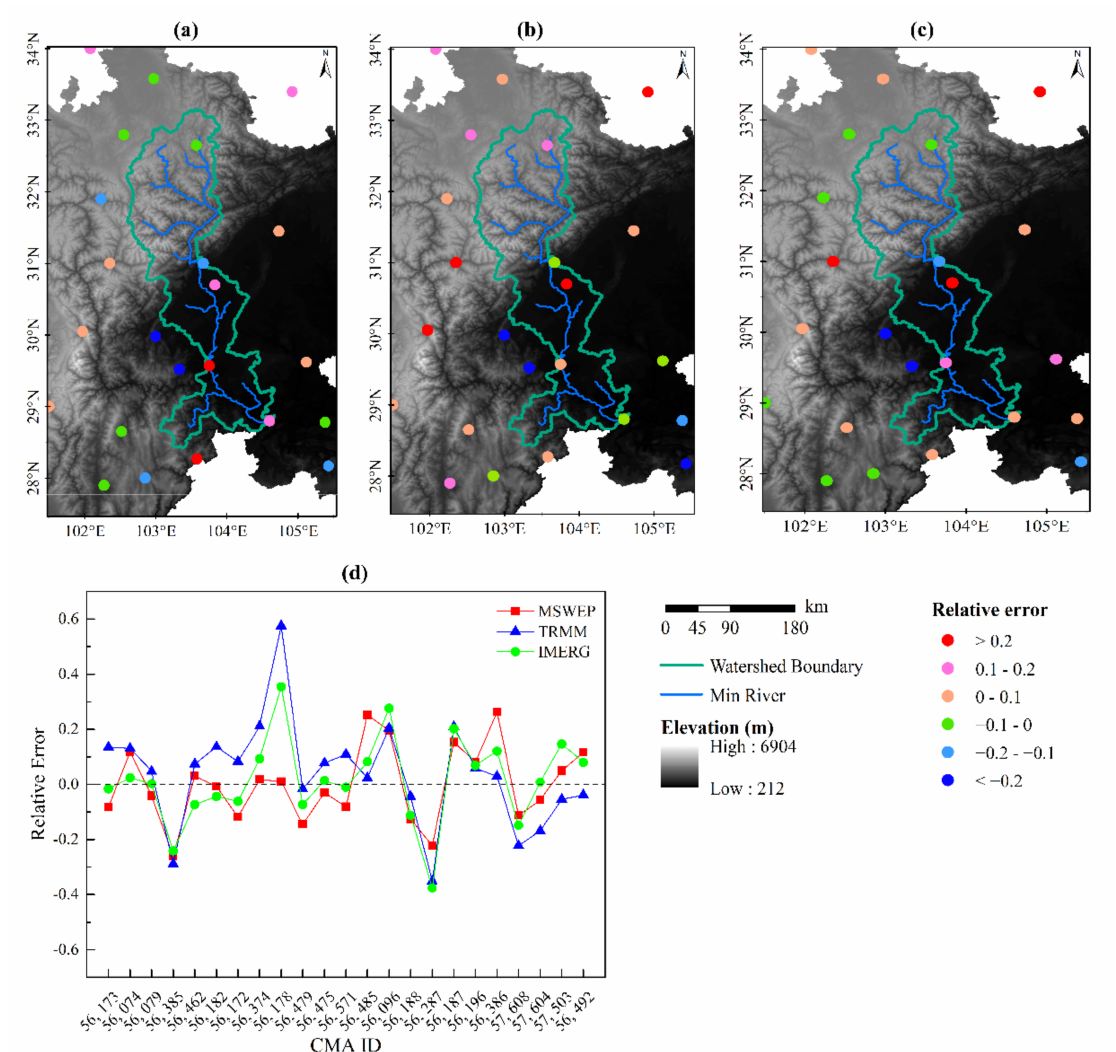
Figure 4. Spatial distributions of relative error (( P − O )/ O ) in monthly average precipitation (mm/day) derived from ( a ) MSWEP, ( b ) TRMM, and ( c ) IMERG products with respect to ground observation data for the period of 2000–2016. ( d ) shows the relative error values for all three products for each ground observation